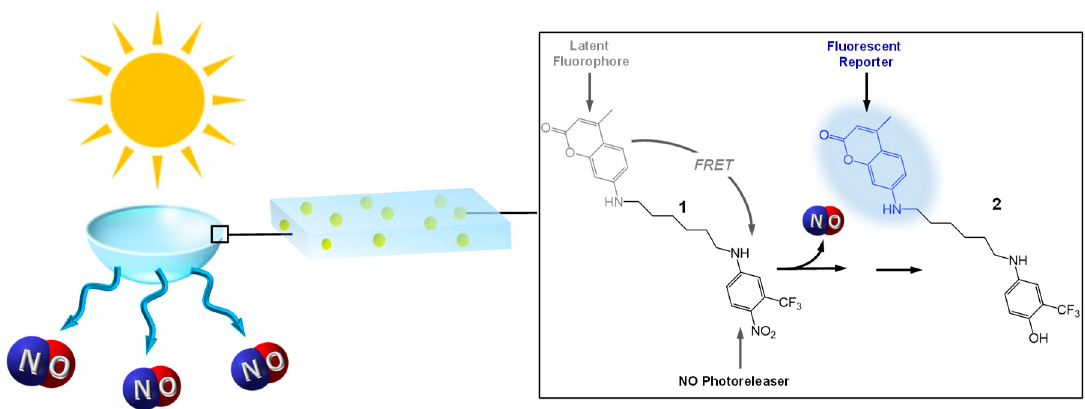
Scheme 1. Schematic for the nitric oxide (NO)-photoreleasing contact lenses (CL) loaded with the NO photodonor (NOPD) 1 and its working principle.